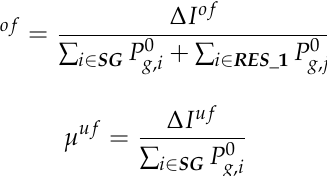
Figure 5. Illustration of Δ𝐼 (cid:3042)(cid:3033) calculation